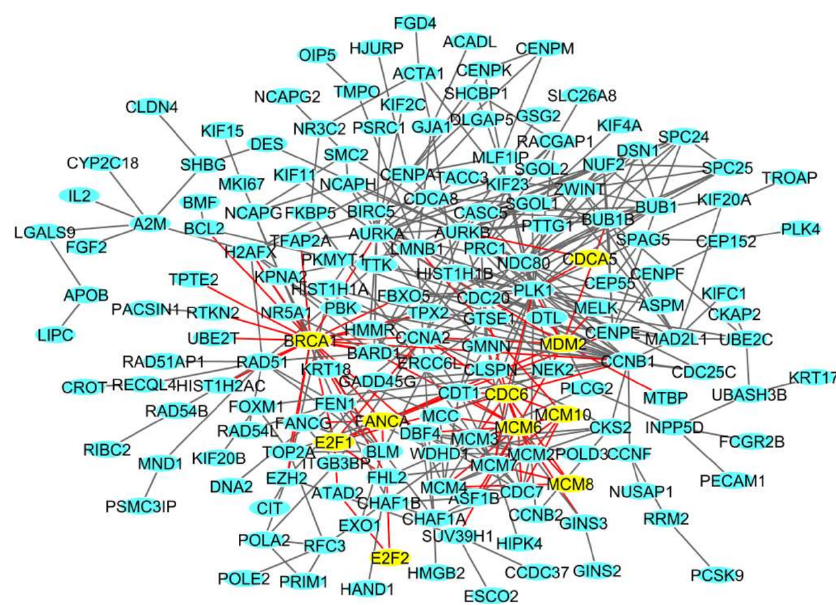
Figure 5. The deregulated densest protein-protein network (blue nodes: proteins, yellow nodes: proteins involved in crucial pathways, red edges: interactions involved yellow nodes) in BCpcEMT BC primary cells: nodes represent genes and edges represent protein